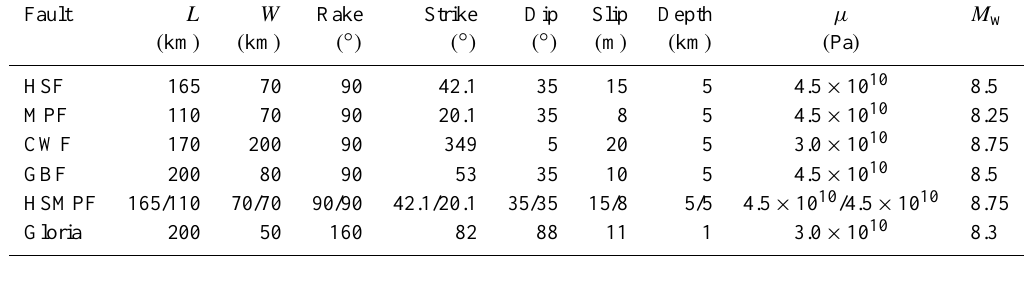
Table 1. Fault parameters of the tsunamigenic sources considered in this study. These parameters have been used for the three different tides MHHW, MSL, and MLLW.